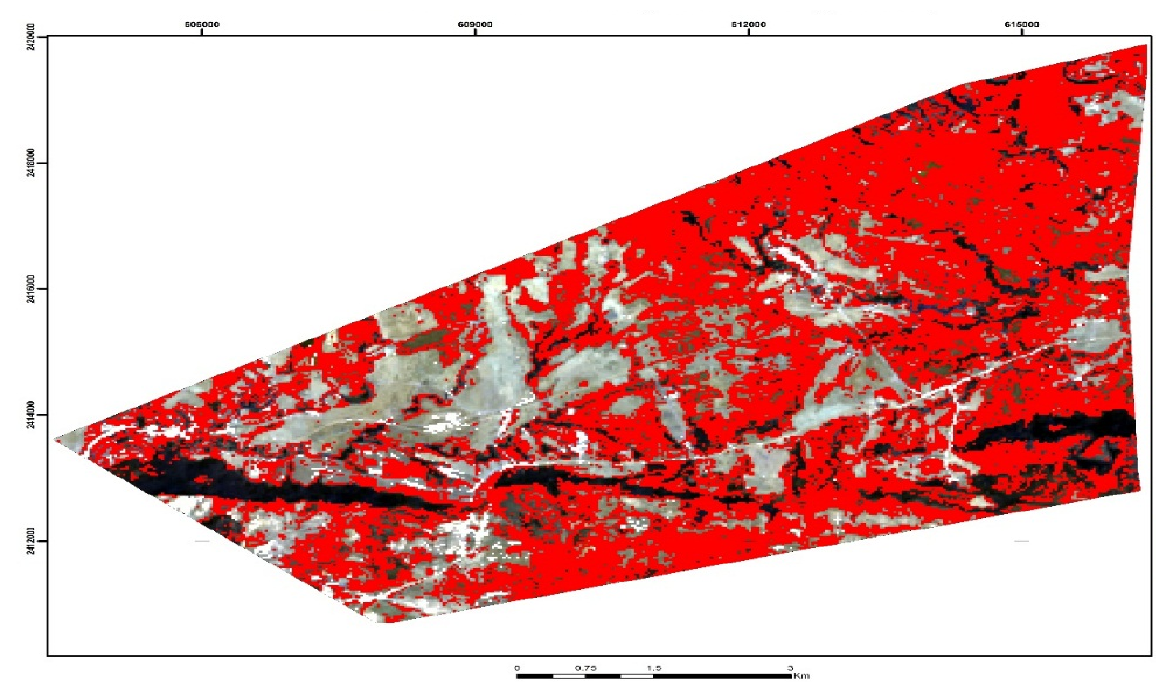
Figure 5. Spatial distribution of sicklebush (shown in red) based on the maximum likelihood classification of a Landsat-8 image of Trinidad-Valle de los Ingenios, Cuba. Datum: WGS1984; Spatial reference: UTM zone 17N; Latitude of origin: 0; Scale factor: 0.9996; Central meridian: − 81; False northing: 0; False easting: 500,000.